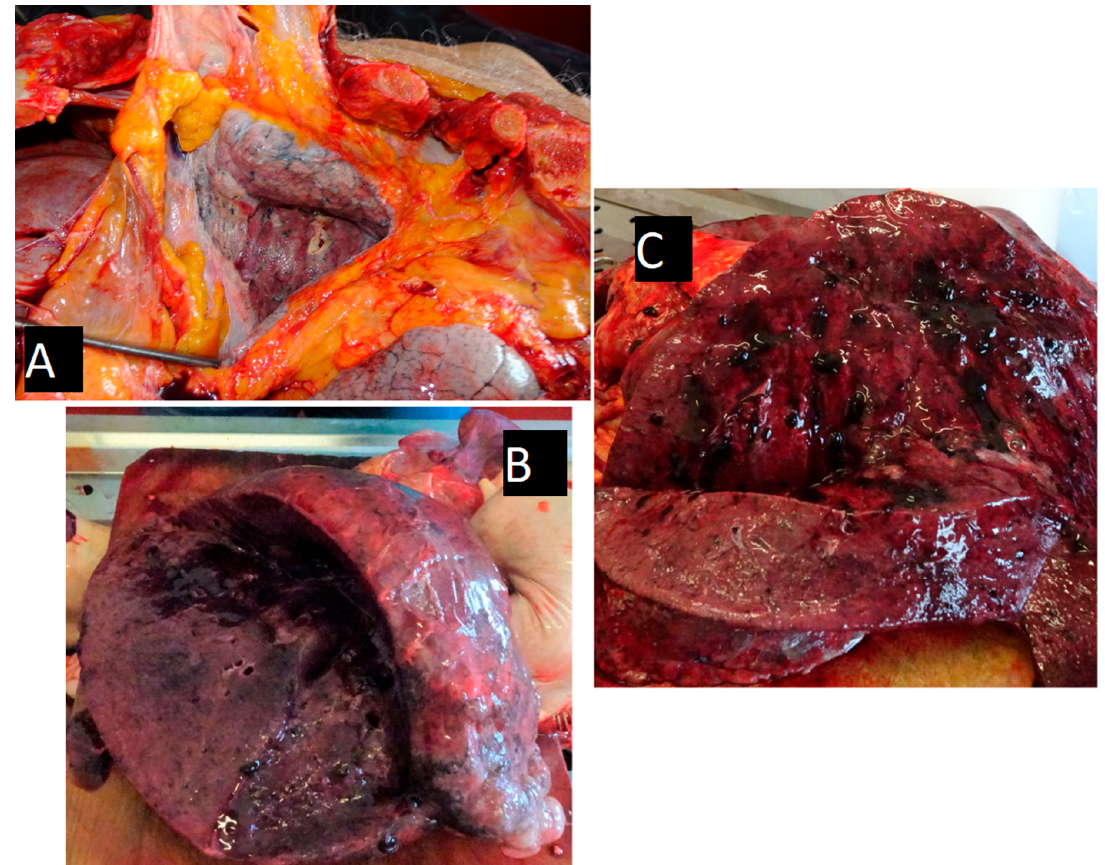
Figure 8. Macroscopic lung aspect during autopsy. Description: Both the left (weight = 740 g, normal = 110–650 g) and the right lungs (weight = 850 g, normal = 150–700 g) were enlarged. No accumulation of fluids were detected in the pleural cavities or pericardial cavity. ( a ) The right pleural cavity presented massive pleural adhesions, with thickened, whitish pleura. ( b ) The left lung showed minimum hemorrhagic petechiae on the pleural surface without signs of pleurisy. A cross section of the lung revealed pulmonary edema and a diffusely firm, condensed, with loss of crepitations in the parenchyma. All of the lobes were affected equally. The bronchi presented little yellowish mucus and the vasculature was patent. ( c ) The parenchyma had pink areas ranging to dark red or brown areas in color with scattered ill-defined hemorrhagic areas; in the right lung parenchyma, mucus plugging was present. The hilar lymph nodes were slightly enlarged, and were black on the cut surface.